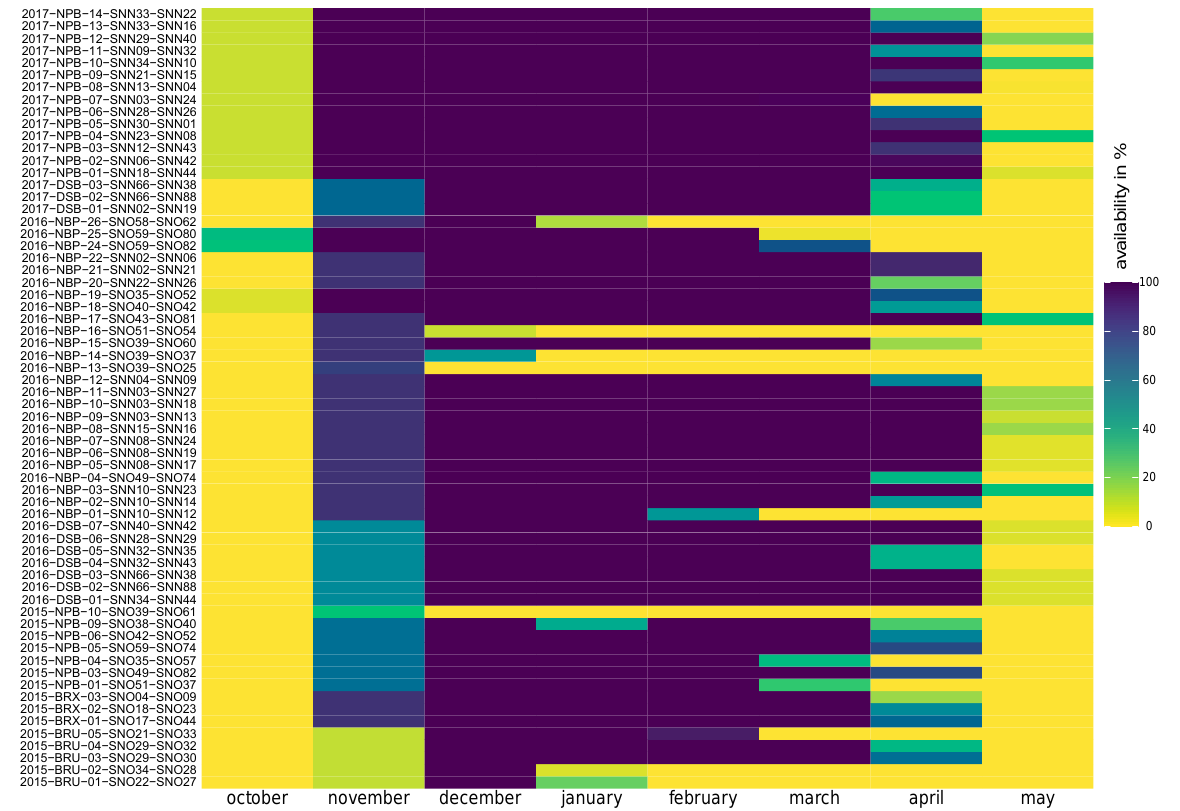
Figure A2. Availability of wind speed values for each station pair.